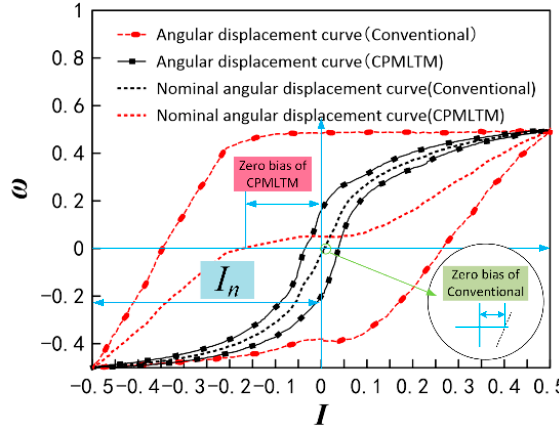
Figure 23. Angular displacement curve.